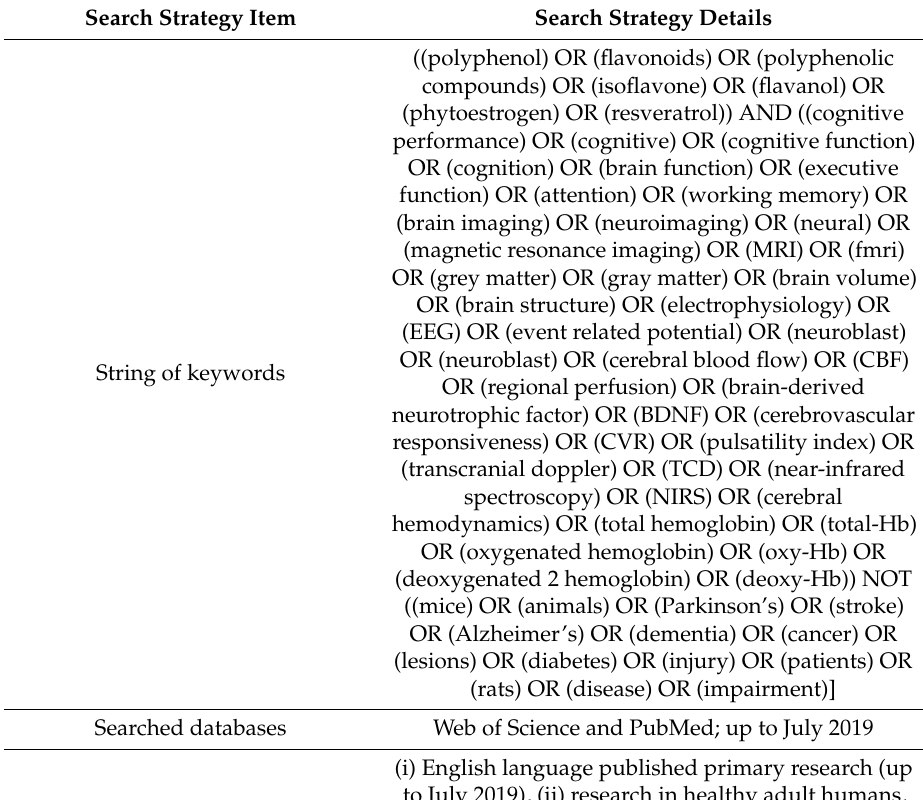
Table 1. A summary of the search strategy and the inclusion and exclusion criteria adopted in the present systematic review and